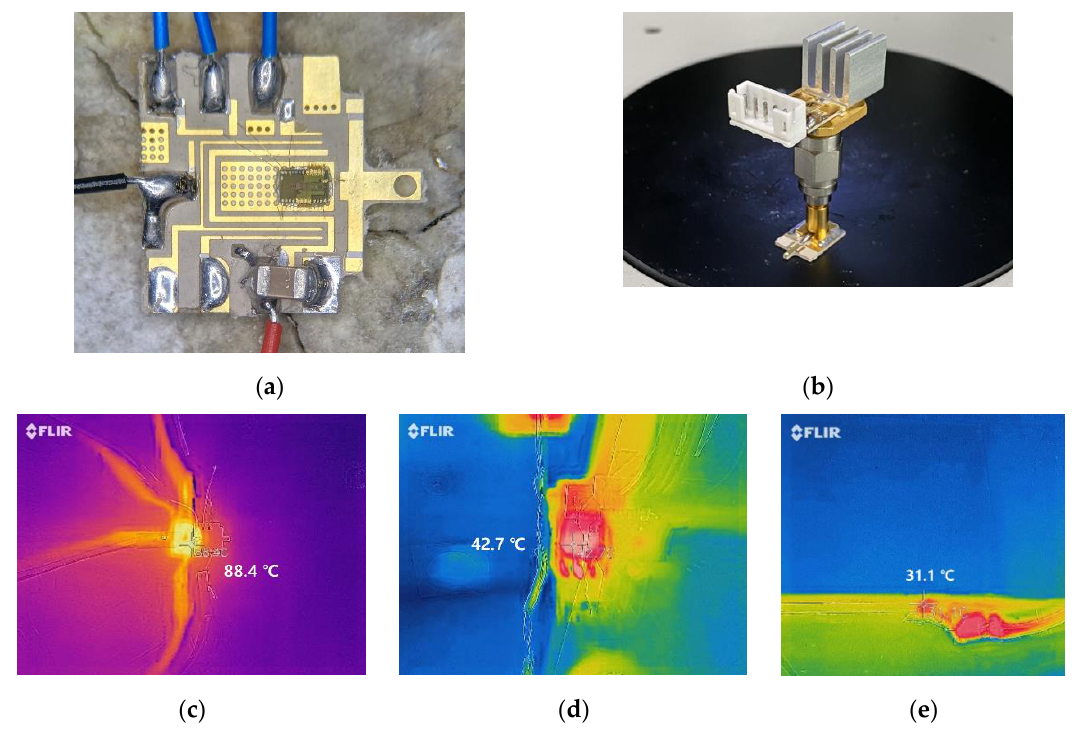
Figure 12. Photograph of the fabricated chip-on-probe ( a ) without and ( b ) with auxiliary PCB, a thermal image with chip temperature under the operation of ( c ) without and ( d ) with auxiliary PCB, ( e ) temperature at the probe bottom surface where mouse brain is contact.